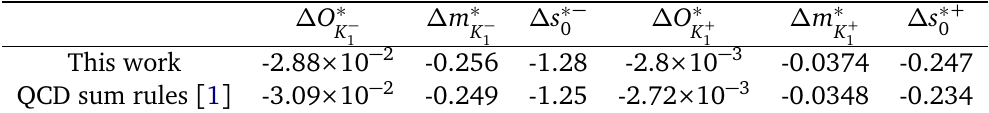
(GeV 2 ), mass ∆ m ∗ K ± 1 ± = 0.16 fm − 3 , T = 0 (GeV 2 ) at ρ N 0